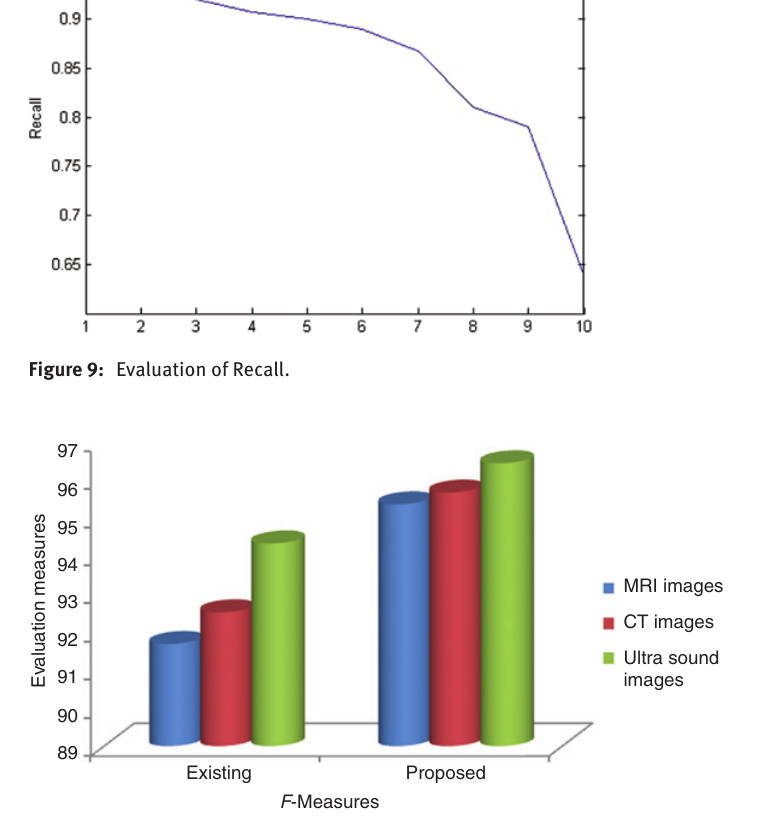
Figure 10: Comparison of Evaluation Measures for F -Measures.